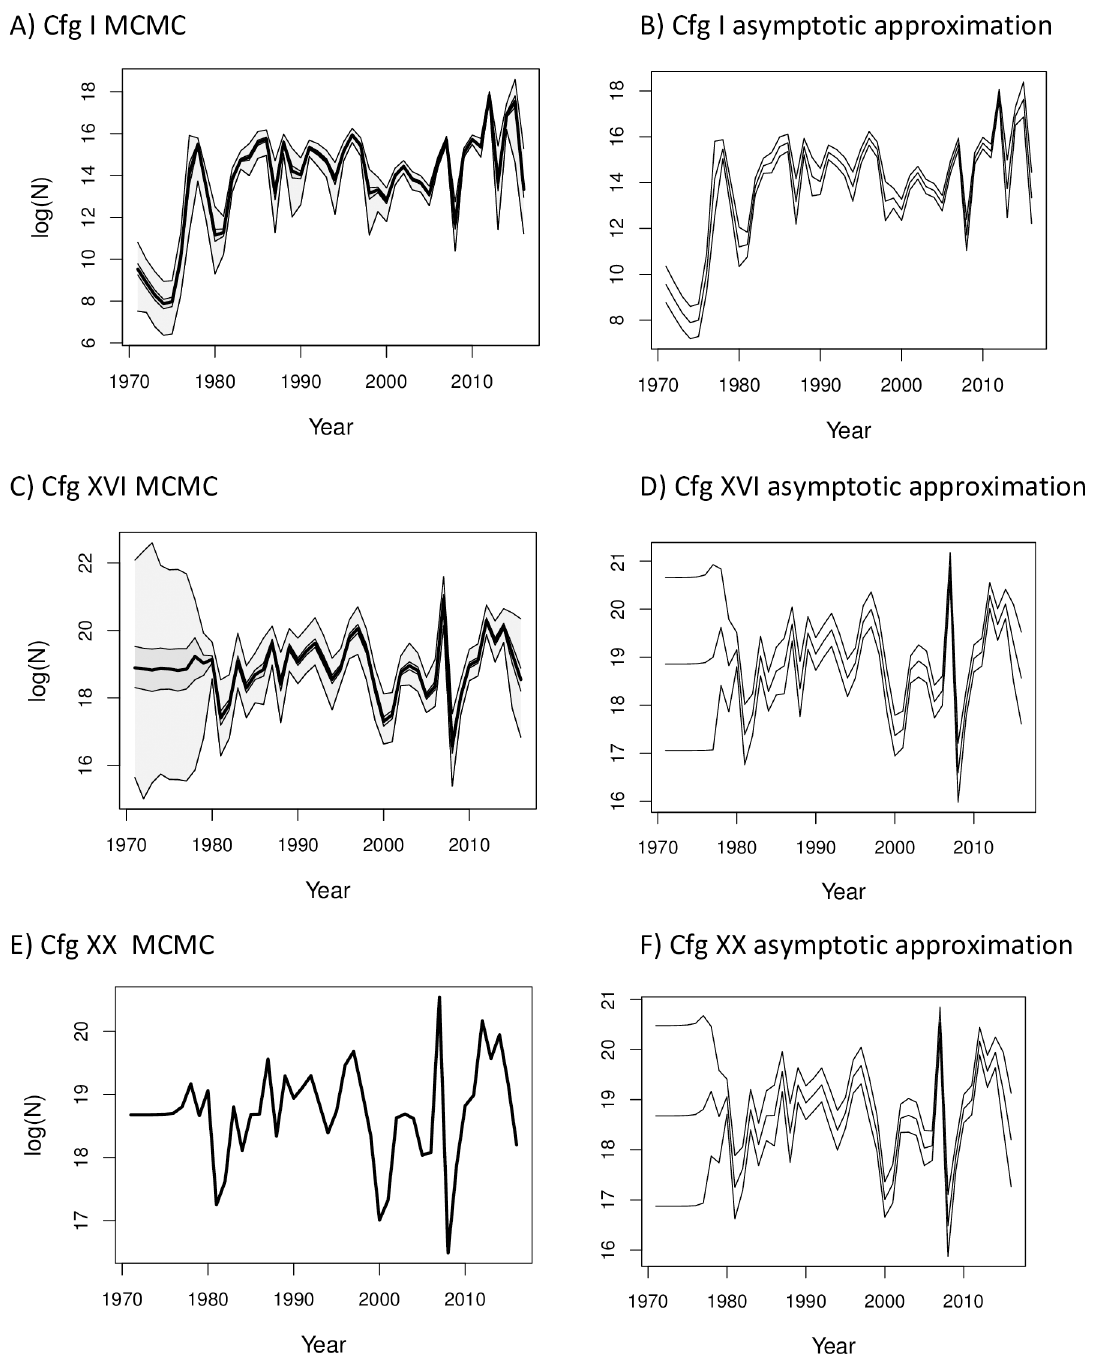
Fig 3. Annual recruitment estimates (where N = number of recruits X 1e+6) and associated uncertainty using MCMC and MLE methods applied to cfgs I, XVI, and XX. MCMC quantiles of 0, 0.25, 0.5, 0.75, and 1.0, and 95% CIs around the MLE from the asymptotic approximation are shown. A) Cfg I MCMC, B) Cfg I asymptotic approximation, C) Cfg XVI MCMC, D) Cfg XVI asymptotic approximation, E) Cfg XX MCMC, F) Cfg XX asymptotic